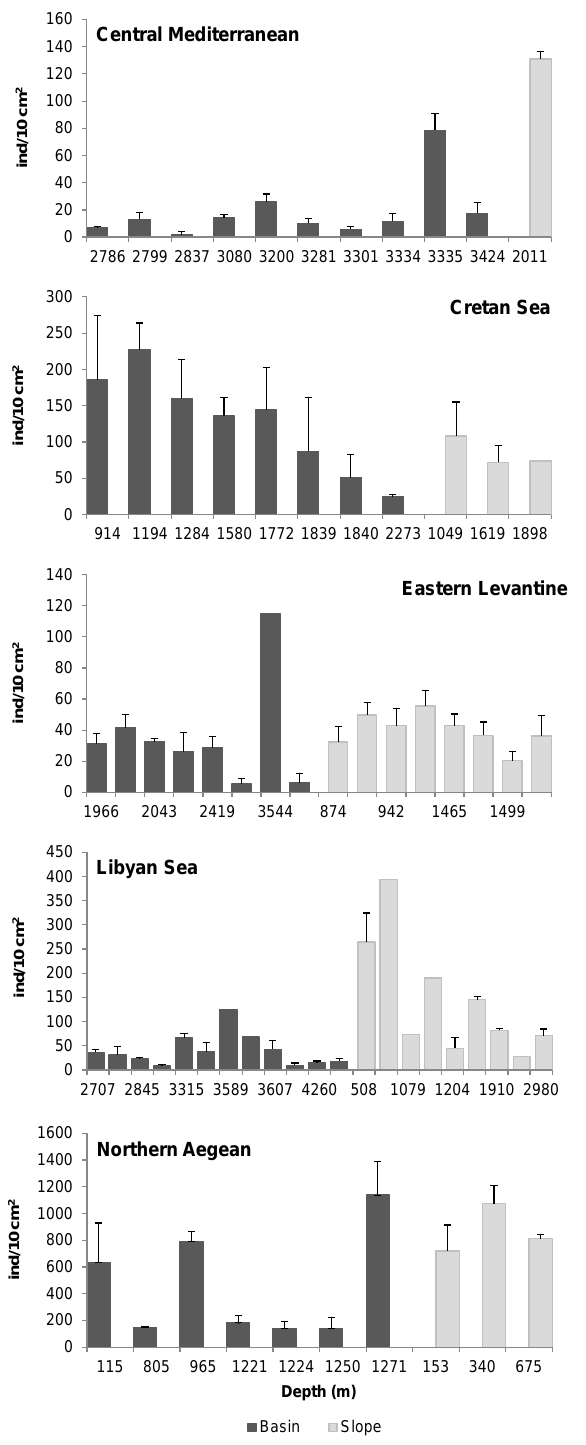
Fig. 3. Nematode abundance per studied area and habitat in relation to depth. Note in x-axis the arrangement of depth in increasing order for each habitat.